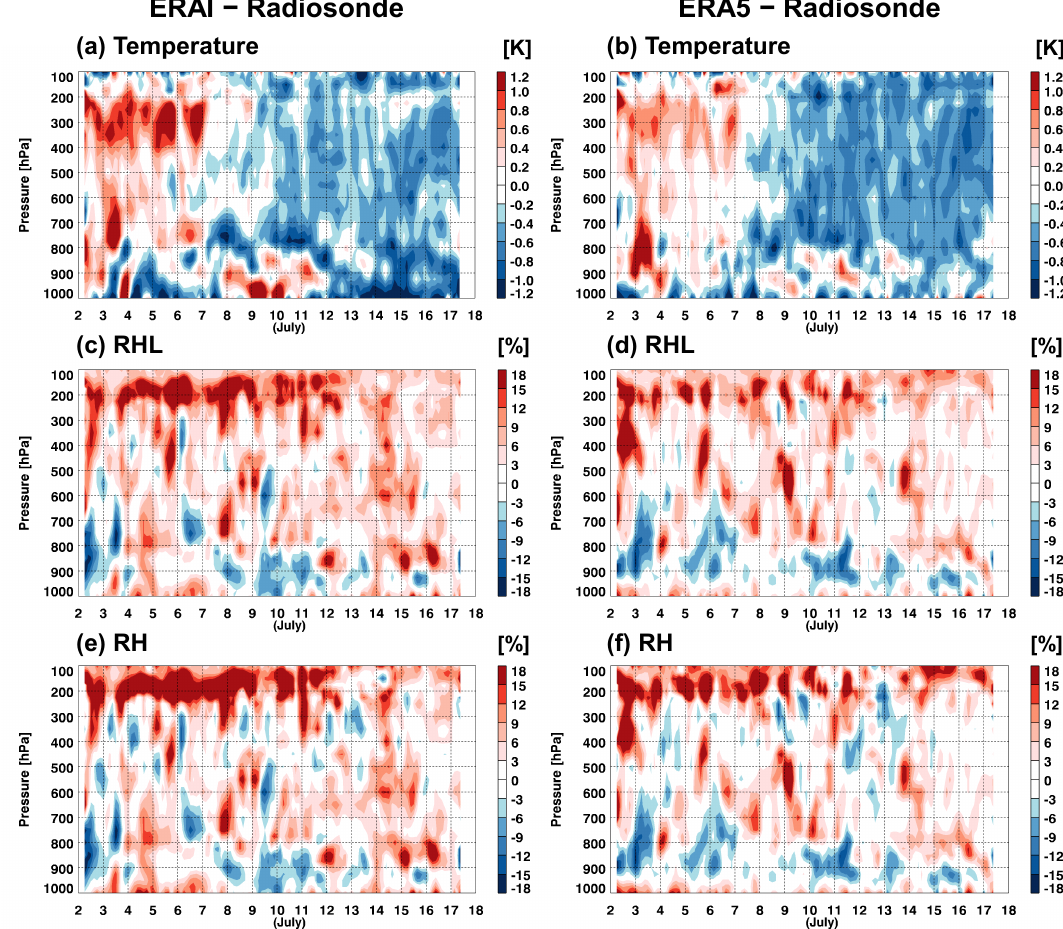
Figure 6. Same as Figure 4, but for the ERAI—Radiosonde ( a,c,e ) and ERA5—Radiosonde ( b,d,e ).